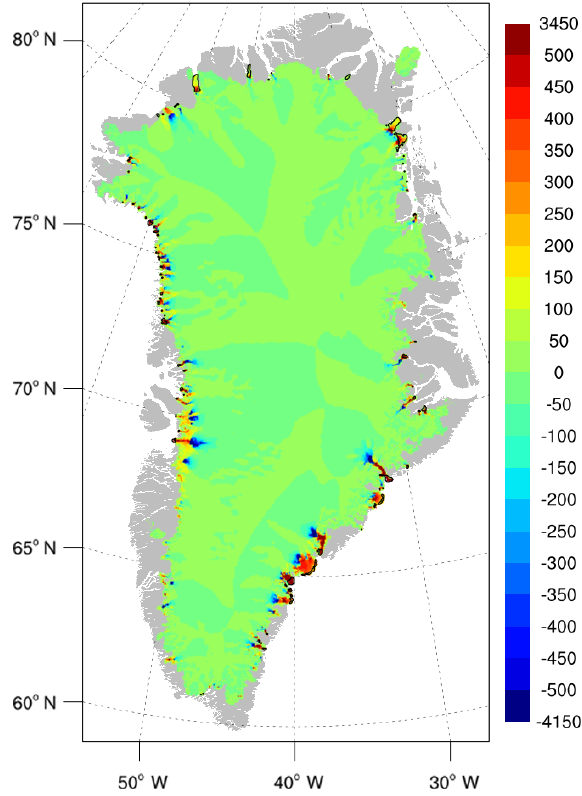
Figure 16. Difference (myr − 1 ) in simulated surface ice speed at the end of 50kyr Greenland spin-up runs with and without ice shelves. Black contours enclose regions that are floating in the run with ice shelves. The gray background shows regions that are ice-free in both